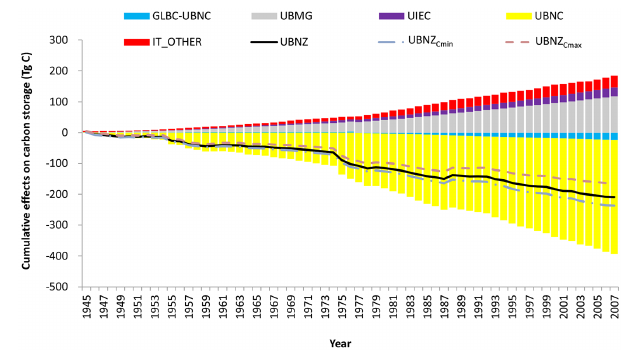
Figure 3. Cumulative effects of urbanization (UBNZ) to the car- bon dynamic of the southern United States from 1945 to 2007 and the contributions of multiple environmental drivers. UBNC is the effect of urban land conversion; GLBC–UBNC is the interac- tive effect between global environmental changes (GLBC, includ- ing changes in climate, CO 2 , N deposition, ozone, and landuse) and UBNC; UBMG is the management effect on the carbon dy- namic of urban vegetation (such as lawn and urban forest); UIEC is the effects due to urbanization-induced environmental changes (such as urban heat island, CO 2 dome effect, and elevated N deposi- tion in urban); the overall interactive effects among UBNC, GLBC– UBNC, UBMG, and UIEC are represented by IT_OTHER. Follow- ing Zhang et al. (2012), UBNZ Cmin and UBNZ Cmax represent the minimum and maximum urbanization effects, respectively, as influ- enced by uncertainties in model parameterization (Table